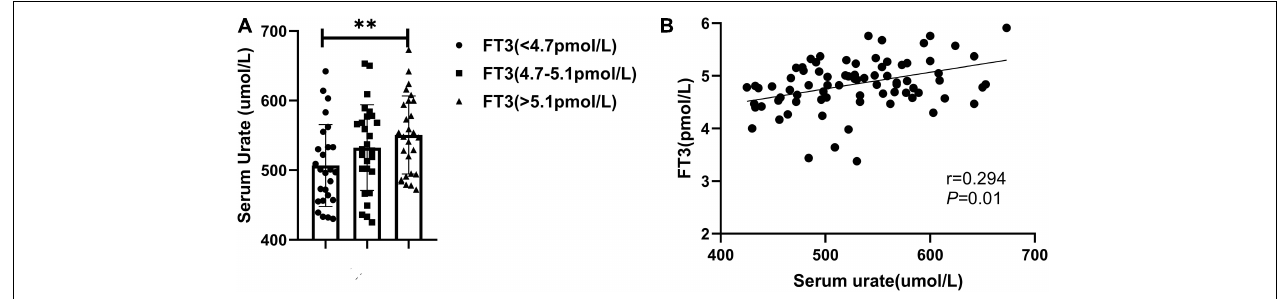
FIGURE 1 | (A) Patients were divided into three groups according to FT3 tertiles ( ∗∗ P < 0.01). (B) A positive correlation was observed between FT3 and serum urate